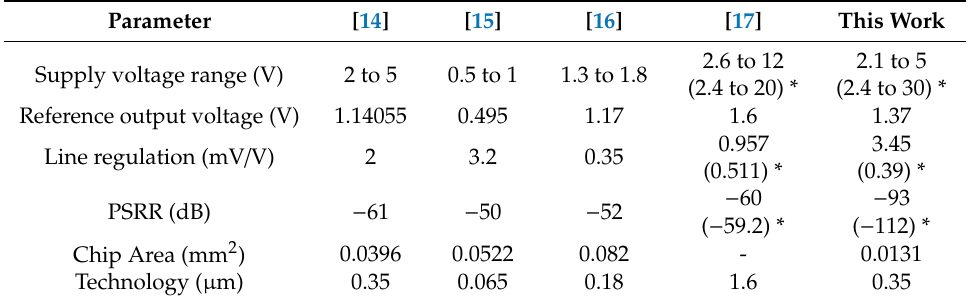
Table 2. Electrical performance summary and comparison of reference circuit with previous designs.